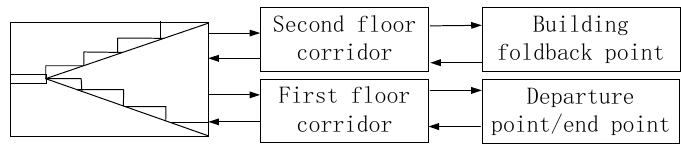
Figure 13. Building environment point feature extraction.